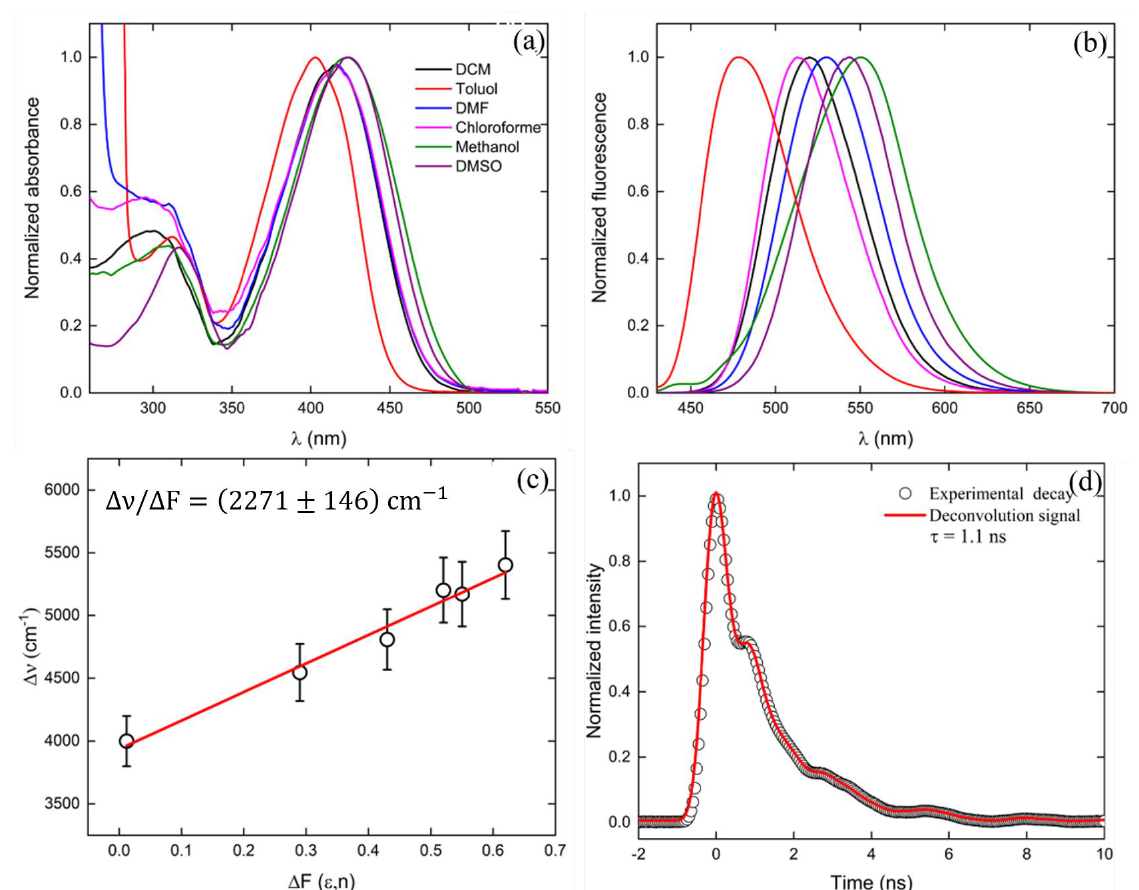
Figure 6. ( a ) linear absorption and ( b ) fluorescence emission of ChN(CH3)2 for different surrounding media (solvents). ( c ) represents the Stoke Shift (in wavenumber units) for different values of solvent polarity (in ascending order of Δ𝐹: toluene, chloroform, dichloromethane, dimethyl sulfoxide, dimethylformamide, and methanol), and ( d ) is the experimental (circles) fluorescence decay. The red line represents the adjustment considering the fluorescence experimental measurements and the instrument response function were convoluted.